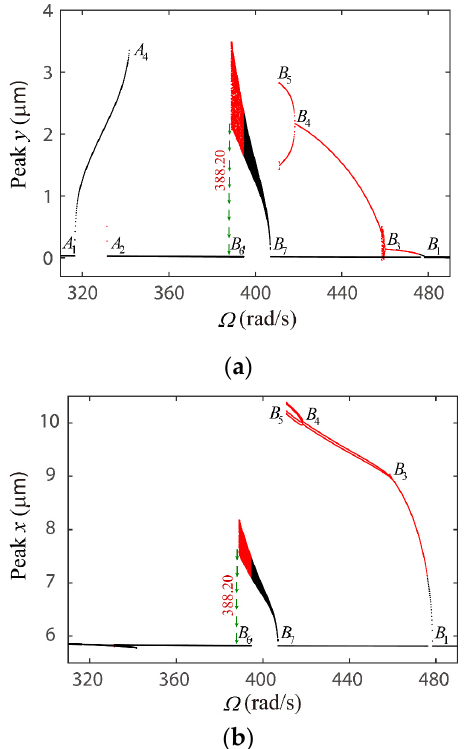
Figure 6. For δ 0 = 1.5 μ m, numerical bifurcation diagrams of local maxima ( a ) y ( τ ) and ( b ) x ( τ ) when Ω sweeps up (black dots) and down (red dots).